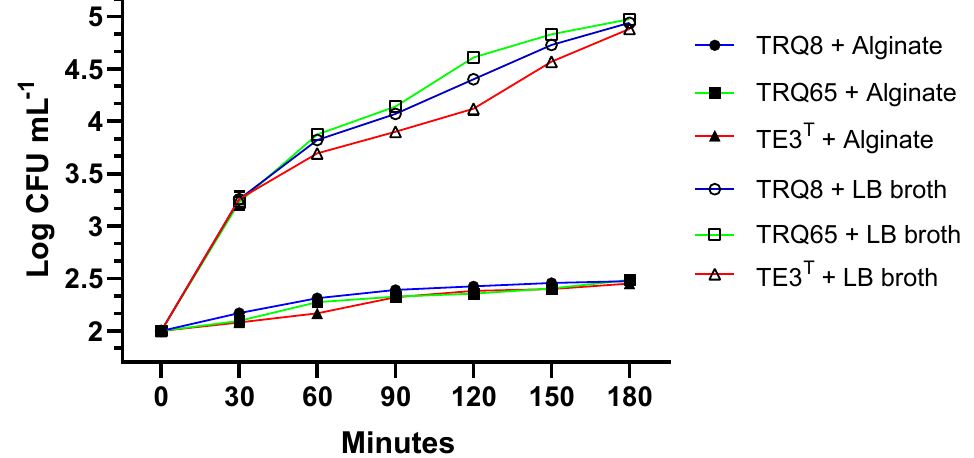
Figure 1. Growth kinetics in sodium alginate, and LB Broth of ( • ) Bacillus megaterium TRQ8, ( (cid:4) ) Bacillus paralicheniformis TRQ65, and ( (cid:78) ) Bacillus cabrialesii TE3 T , growing at 32 ◦ C, and 150 rpm. Bars represent the standard deviation.